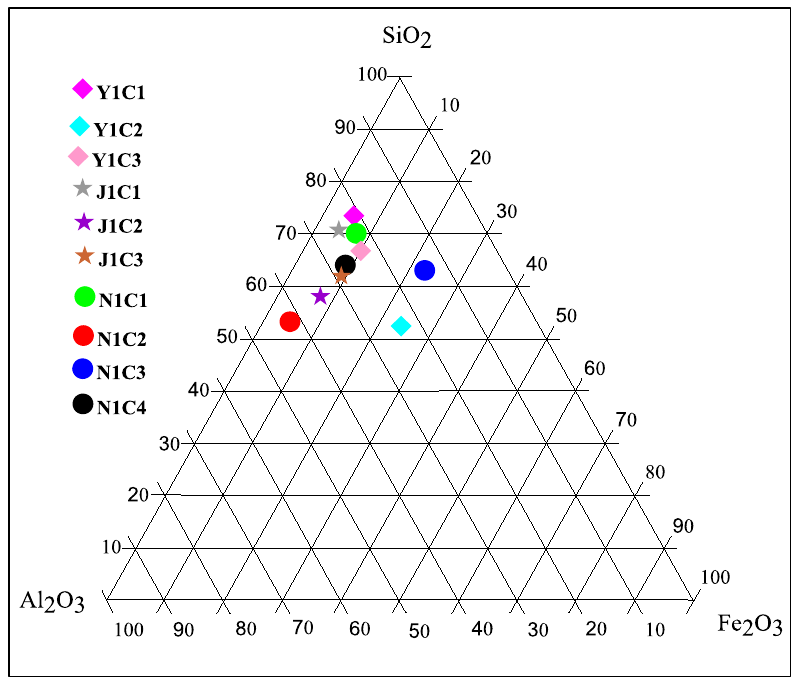
Figure 7. Position of clay materials of the eastern part of the Douala sub-basin in the triangular diagram SiO 2 -Al 2 O 3 -Fe 2 O 3 .